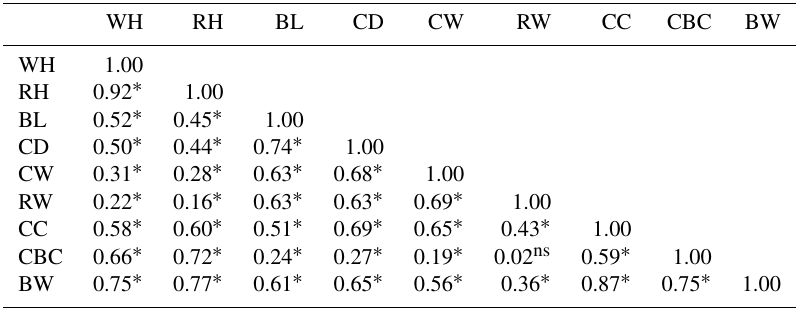
Table 3. Pearson’s correlation coefficients between the morphometric traits of investigated sheep breeds. WH RH BL CD CW RW CC